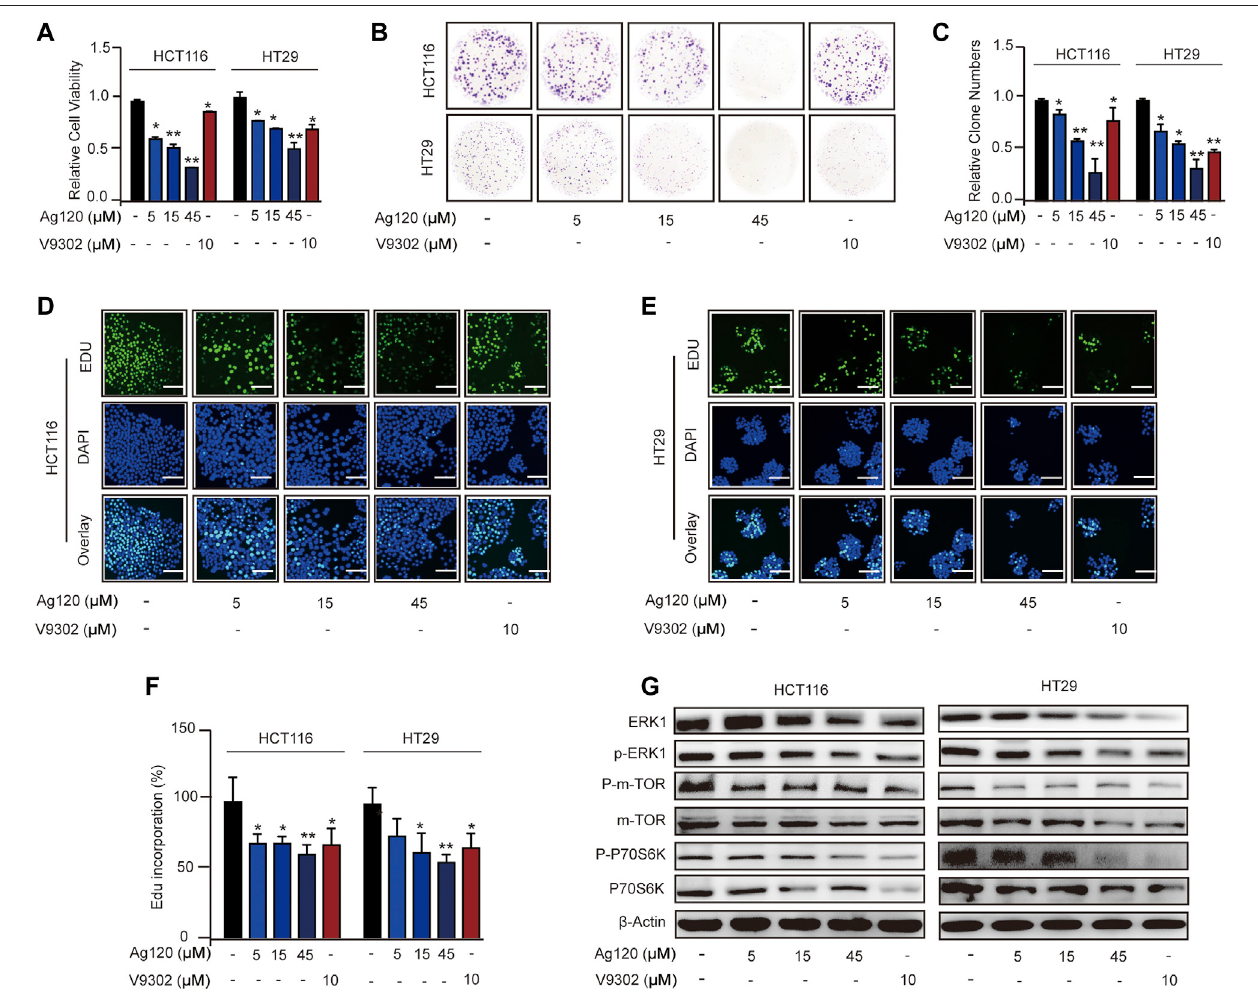
FIGURE 2 | Ag120 inhibits CRCcell proliferation via suppression of ERK and mTOR signaling pathways. (A) Quanti fi cation of HCT116 and HT29 cells after culture for72 hwithAg120orV9302wasperformedusingaCCK-8kit. (B,C) Plateimages (B) andquanti fi cation (C) ofcolonyformationbyHCT116andHT29cellsculturedfor 10 days with Ag120 or V9302. (D – F) Fluorescence microscopy images (D,E) and quanti fi cation (F) of EdU incorporation in HCT116 and HT29 cells cultured for 3 days with Ag120 or V9302. Scale bars, 50 µm. (G) Immunoblot analysis of ERK1, p-ERK1, mTOR, p-mTOR (S2448), P70S6K, and p-P70S6K expression in CRC cells treated with Ag120 or V9302 for 72 h. Mean ± SD of at least three independent experiments. ns, no signi fi cance; * p < 0.05, ** p < 0.01 by Student ’ s t